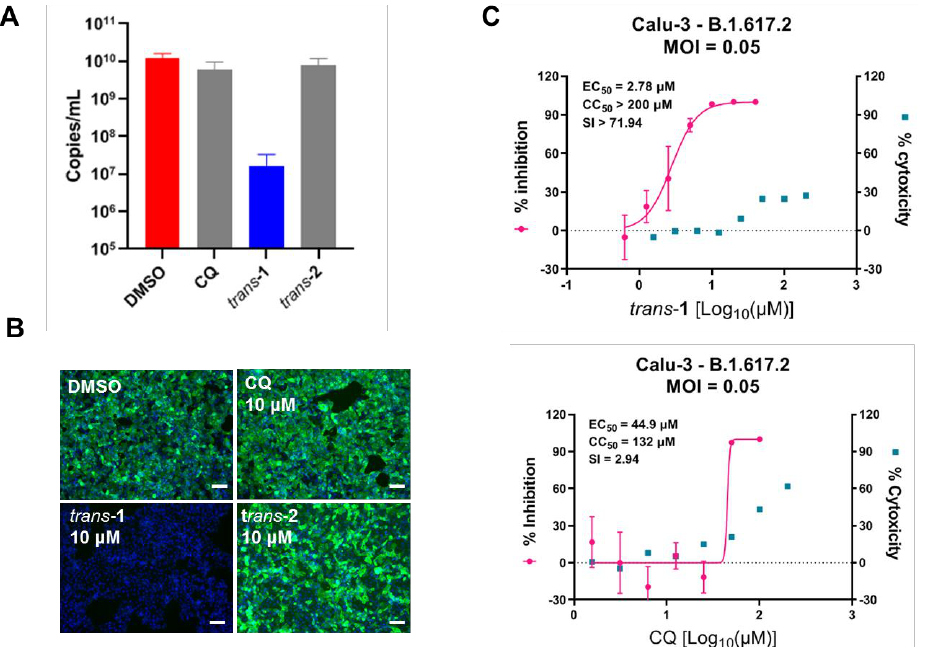
Figure 4. Compound trans - 1 exhibits potency in the inhibition of SARS-CoV-2 replication in Calu-3 cells. A single dose of 10 µ M of CQ, trans - 1 , or trans - 2 , was used to treat Calu-3 cells, followed by SARS-CoV-2 (B.1.617.2) infection at an MOI of 0.05 for 48 h. The supernatant and the infected cells were harvested to measure the production of viral progeny ( A ) and the immune staining of the NP ( B ), respectively. The scale bar of immunofluorescence image in ( B ) is 200 μm. ( C ) Dose-dependent effects of trans - 1 and CQ on SARS-CoV-2 (B.1.617.2) on Calu-3 cells. Calu-3 cells were treated with the indicated concentration of trans - 1 or CQ and were infected with SARS-CoV-2 (B.1.167.2) at an MOI of 0.05 for 48 h. The supernatant was quantified for the production of viral progeny, and the inhibition rate was normalized to that of the DMSO vehicle control group. Combined with the cytotoxicity data of each compound, the dose − response curves of the inhibition rate and cytotoxicity were generated using GraphPad Prism 8 software.